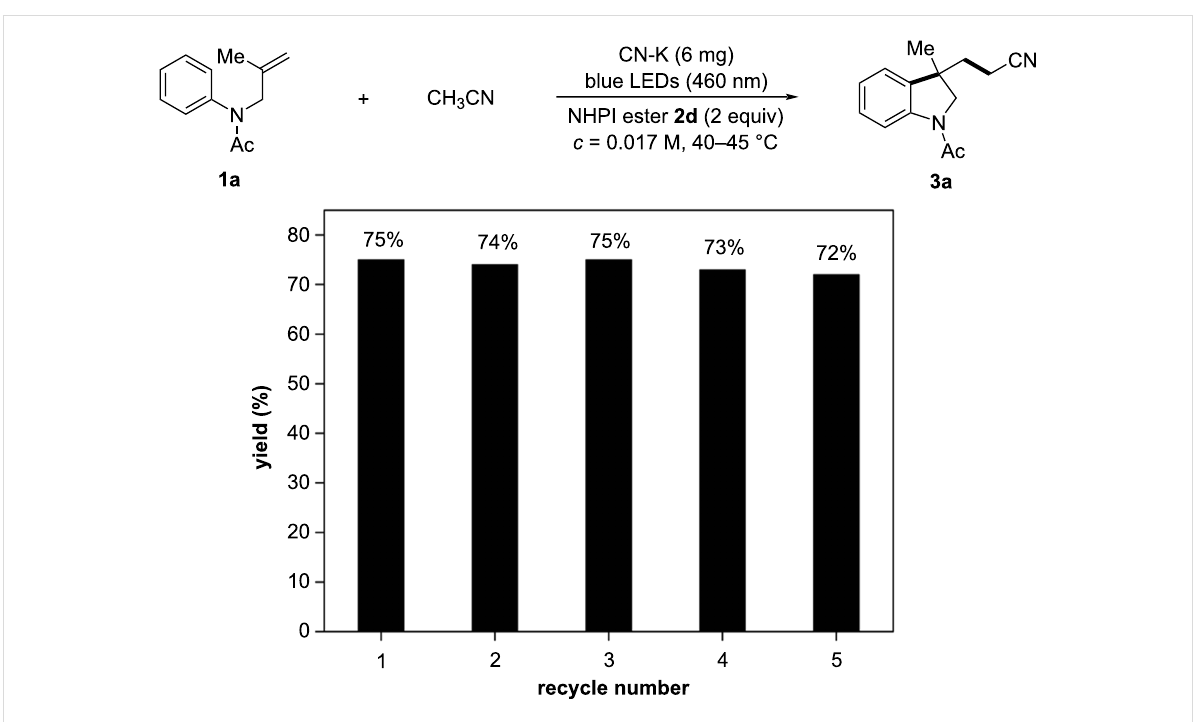
Figure 1: Evaluation of catalyst recycling. Reaction conditions: 1a (0.1 mmol, 1 equiv), 2d (0.2 mmol, 2 equiv), CH 3 CN (6 mL), CN-K (1 mg/mL), 2 × 24 W blue LEDs (460 ± 5 nm) without extra heating (at 40–45 °C). After each reaction, the catalyst was recovered by centrifugation and reused in the next